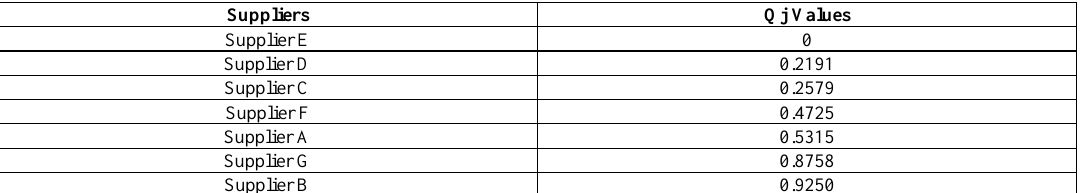
Table 10. Ranking of